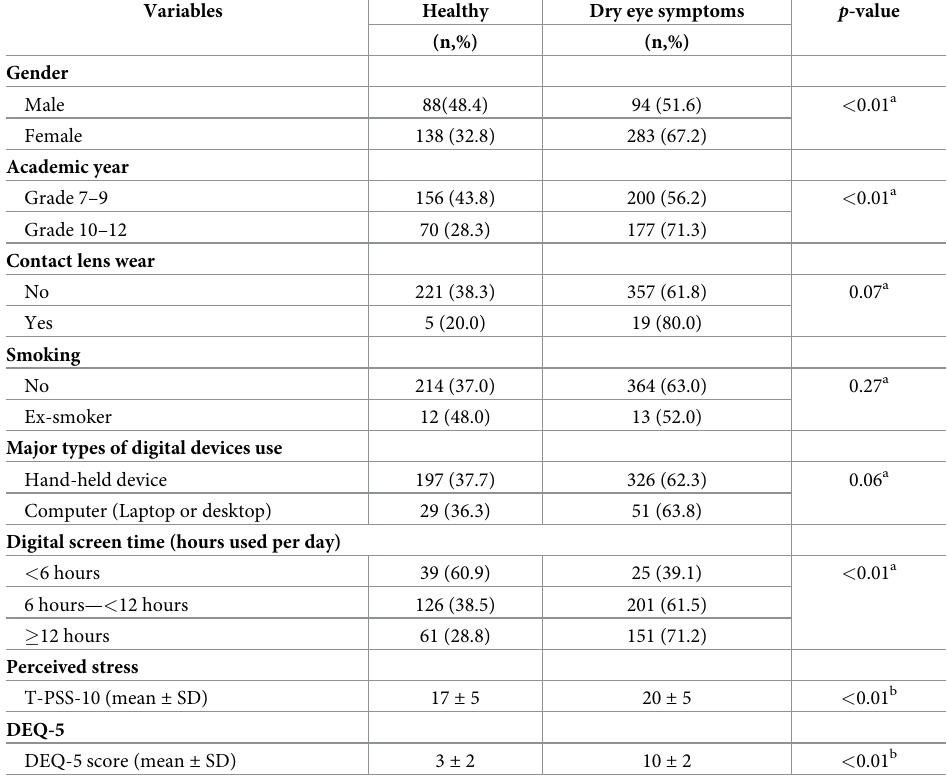
Table 2. General demographics between healthy respondents and those with symptoms of dry eye (N =